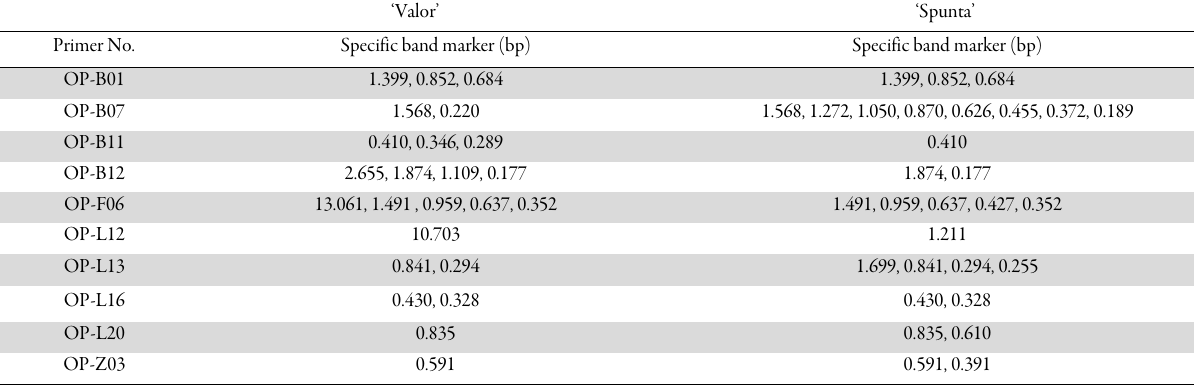
Table 4. Used primers and the specific RAPD markers generated for gamma radiation treatments ‘Valor’ ‘Spunta’ Primer No.